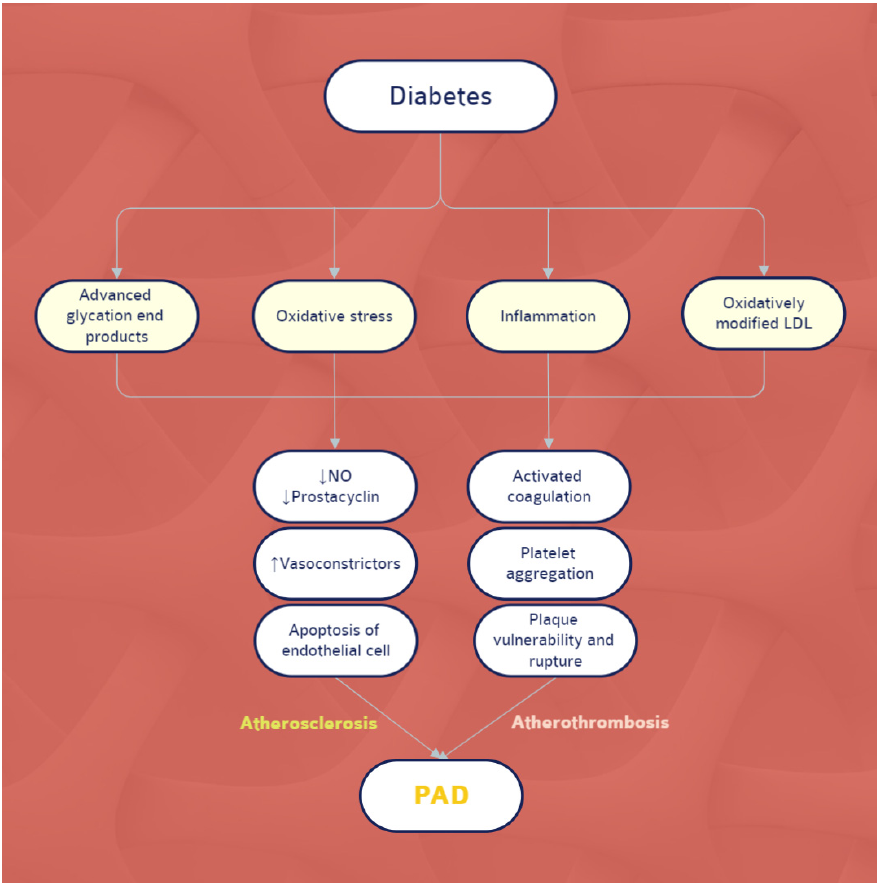
Figure 1. The pathophysiological hallmarks of PAD in DM. Abbreviations: NO, nitric oxide; LDL, low-density lipoprotein; PAD, peripheral artery disease.